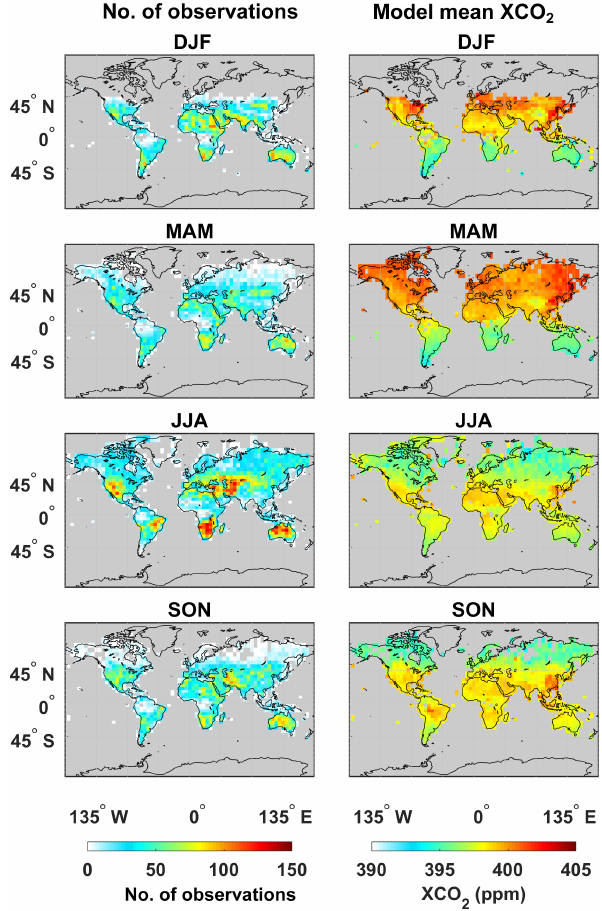
Figure 5. Seasonally averaged XCO 2 range from GEOS-Chem forward model simulations using the four prior biosphere mod- els (NASA-CASA, CASA-GFED, SiB-4, and LPJ) (left column) and the corresponding posterior estimates (right column) from the OSSE simulations. The synthetic observations in these OSSE sim- ulations correspond to the OCO-2 LN + LG observing